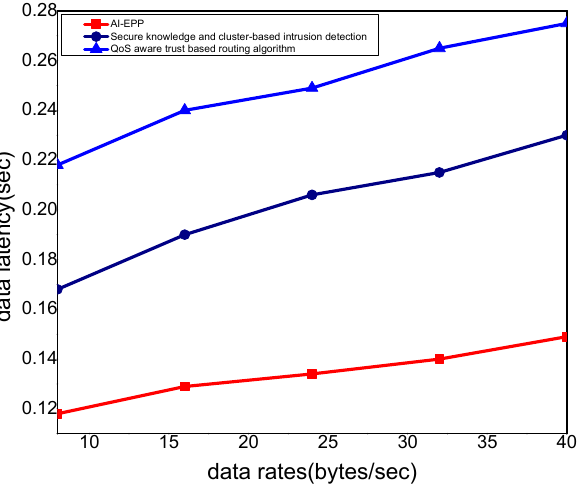
Figure 6. Data latency comparison using simulations with varying data rates.